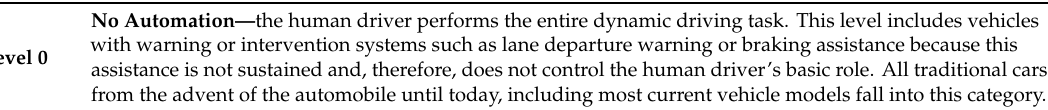
Table 1. SAE International’s levels of